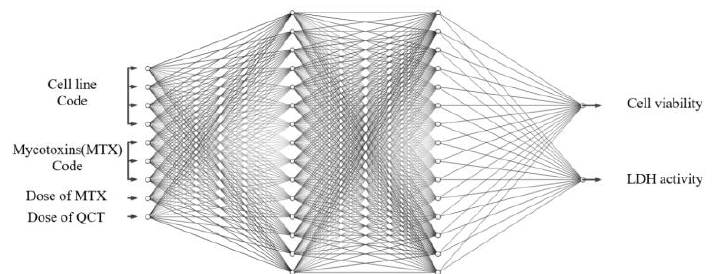
Figure 11. Architecture of ANN which was used for the modeling of cell viability and LDH activity. The size of the ANN is 9-10-10-2. Biases of nodes are omitted in this figure.